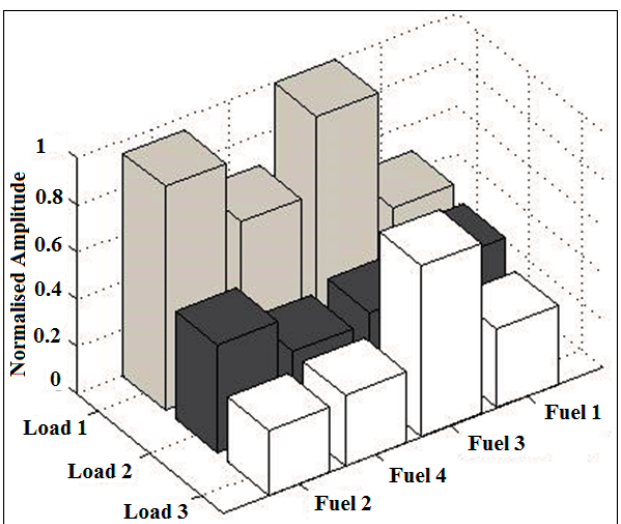
Figure 7. Comparison of normalized amplitude over entire bandwidth for Fuels 1–4 at Loads 1–3.